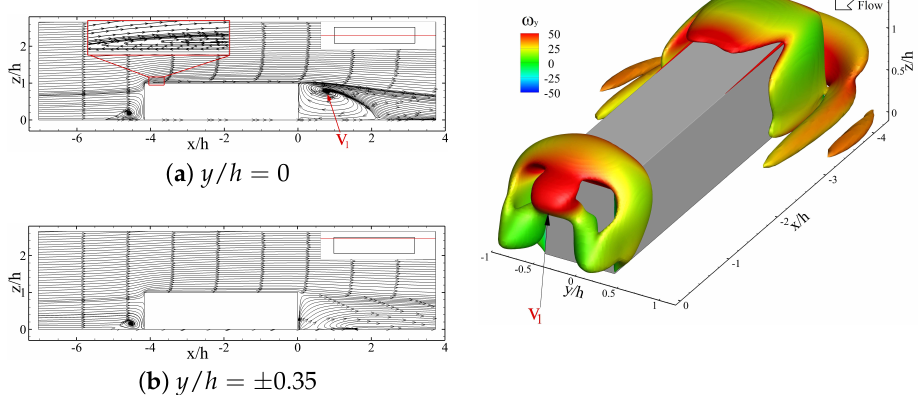
Figure 15. Isosurface of Q ∗ = 4.42 × 10 − 2 overlaid by the contour of y -component of vorticity and side view of the wake structure of the long